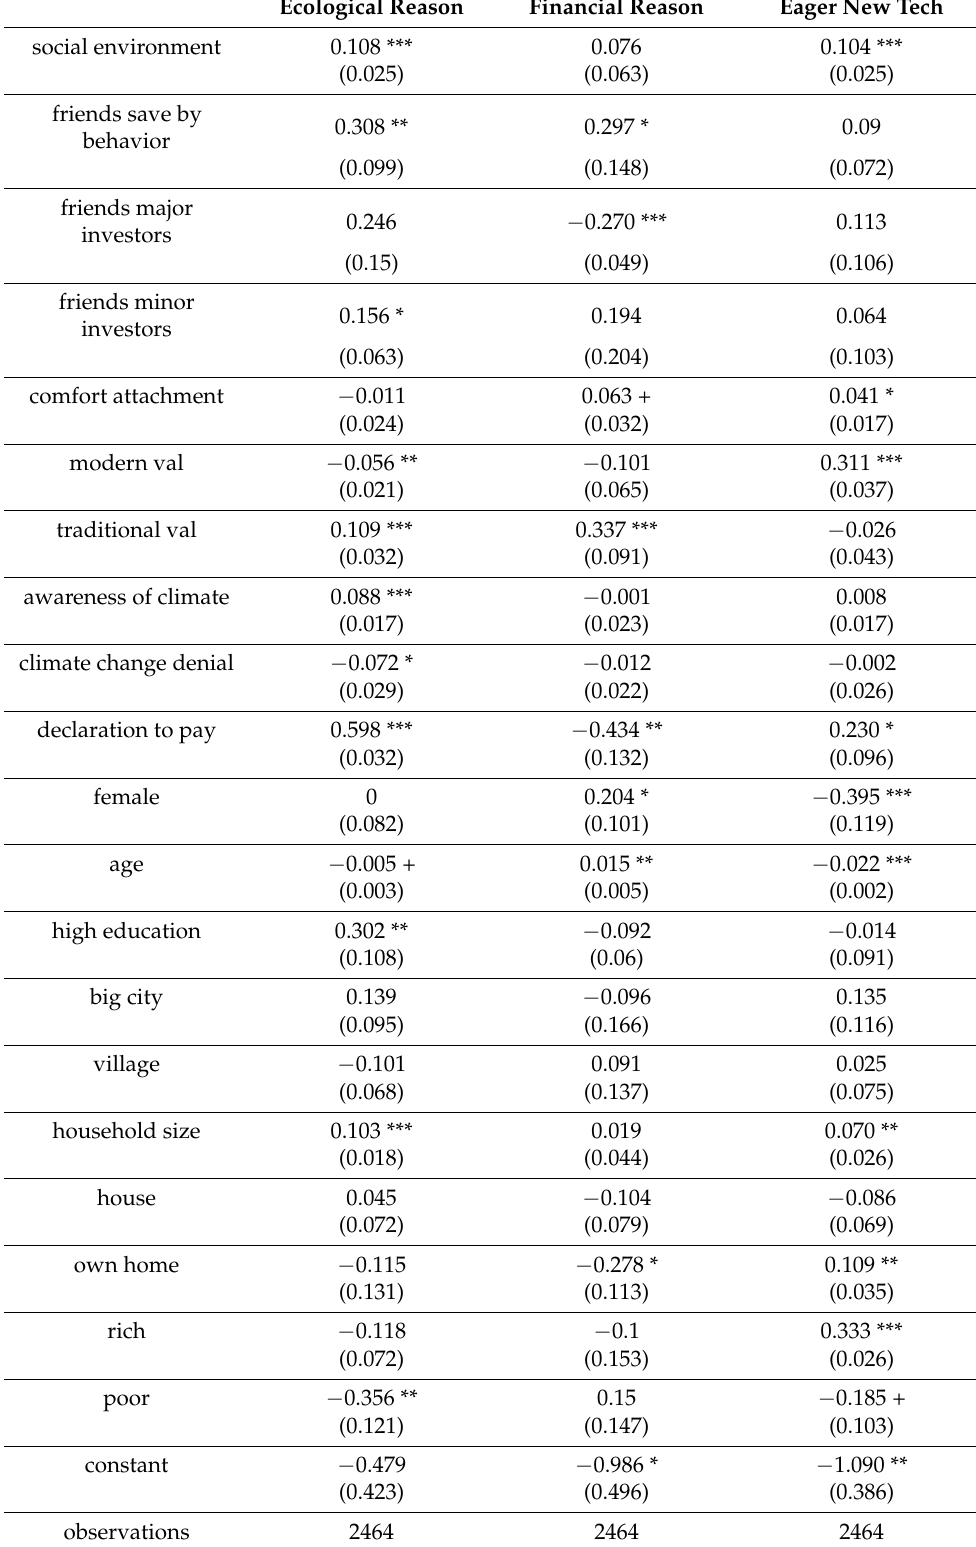
Table 2. Results from the GSEM, part II. Authors’ own analysis, based on data obtained during an online questionnaire completed in four countries. + p < 0.10, * p < 0.05, ** p < 0.01, *** p < 0.001, the standard errors clustered in countries are reported in